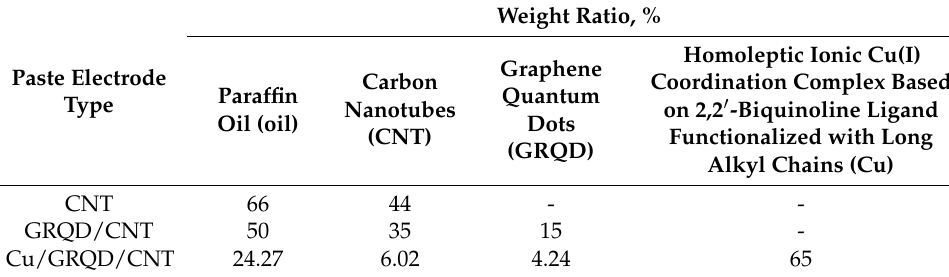
Table 1. The weight ratio of the working paste